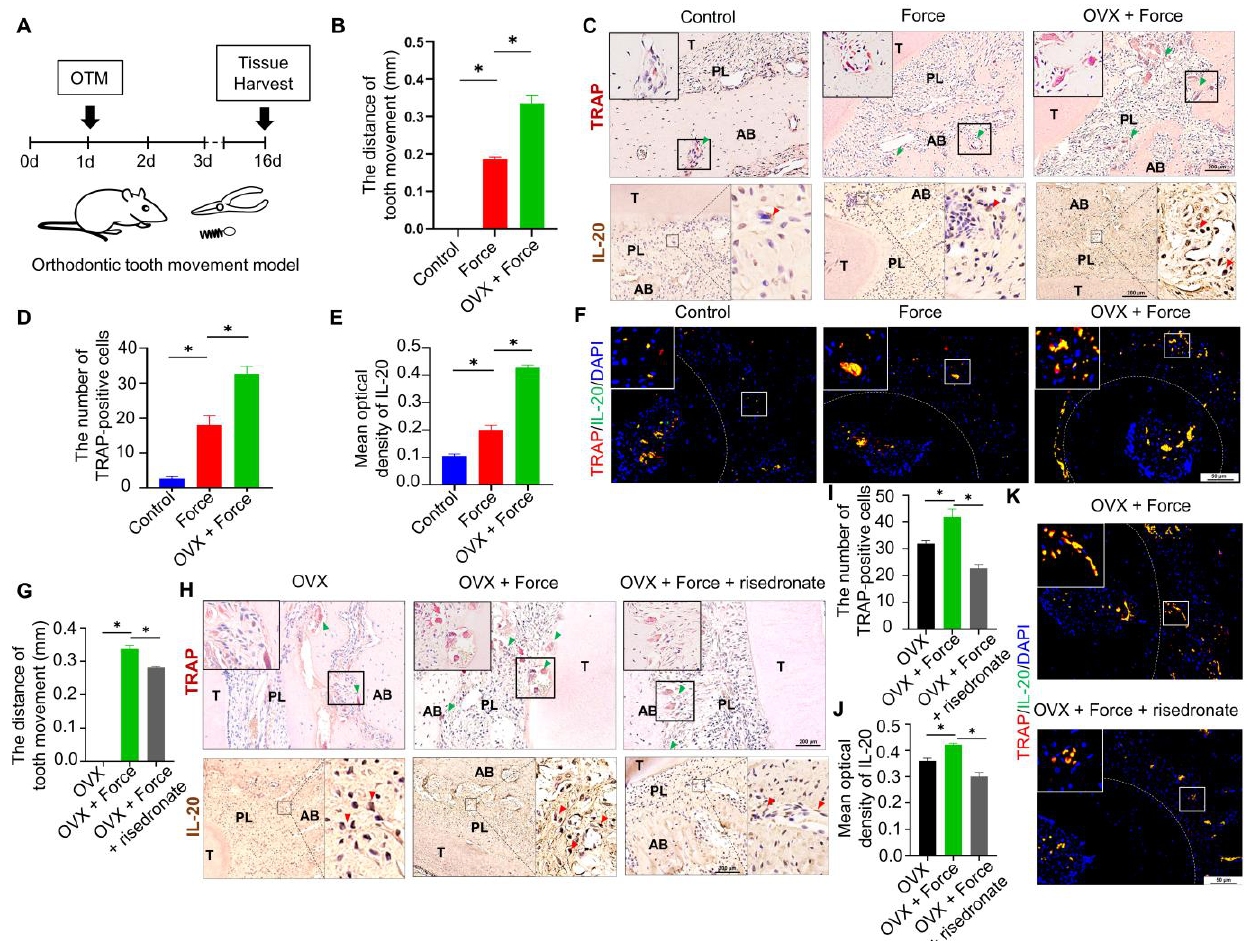
Figure 1. IL-20 accelerated OVX-induced bone loss in orthodontic tooth movement by promoting osteoclastogenesis. ( A ) Scheme illustrating the establishment of orthodontic tooth movement. ( B ) The distance of orthodontic tooth movement in the Control group, Force group, and OVX + Force group on day 16. ( C ) TRAP and Immunohistochemical staining showed that TRAP and IL-20 -positive cells and in the Control group, Force group, and OVX + Force group. Green triangles showed TRAP-positive osteoclasts. Red triangles showed IL-20-positive cells. T: tooth, PL: periodontal ligament, AB: alveolar bone. ( D ) The quantification of TRAP-positive osteoclasts in the Control group, Force group, and OVX + Force group. ( E ) Immunohistochemical staining and semiquantification of IL-20 in the Control group, Force group, and OVX + Force group. ( F ) Double-labelled immunofluorescence staining showed that, in the context of orthodontic force, the expression levels of IL-20 and osteoclast marker protein TRAP increased in the first molar periodontal ligament. ( G ) The distance of orthodon- tic tooth movement in the OVX group, OVX + Force group, and OVX + Force + risedronate group on day 16. ( H ) TRAP and immunohistochemical staining showed that TRAP and IL-20 -positive cells and in the OVX group, OVX + Force group, and OVX + Force + risedronate group. ( I ) The quantification of TRAP-positive osteoclasts in the OVX group, ovariectomy + Force group, and Ovariectomy + Force + risedronate group. ( J ) Immunohistochemical staining and semiquantification of IL-20 in the OVX group, OVX + Force group, and OVX + Force + risedronate group. ( K ) Im- munofluorescence staining showed that the expression levels of IL-20 and osteoclast marker protein TRAP increased in the first molar periodontal ligament. * p < 0.05 vs. the control group. n =